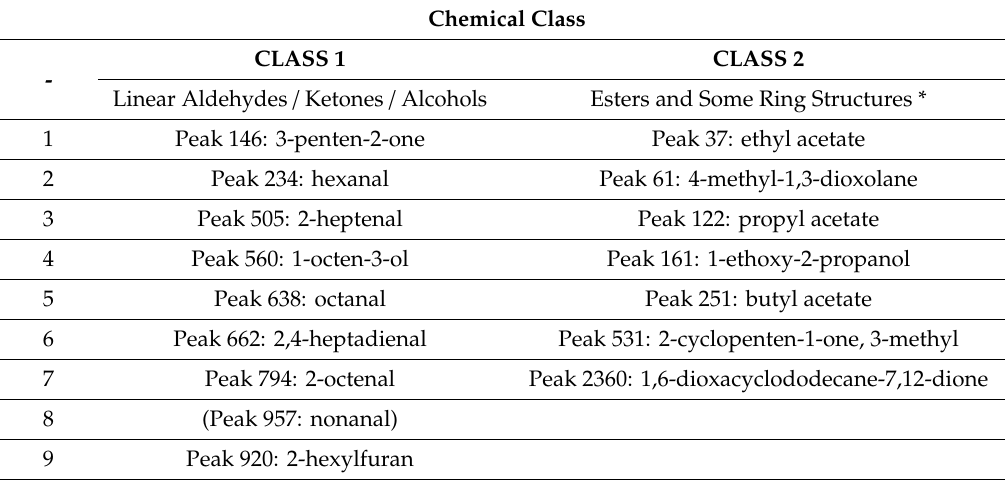
Table 3. Significant compounds by class 1 and class 2 compounds using Tukey–Kramer, all pairs testing with p <